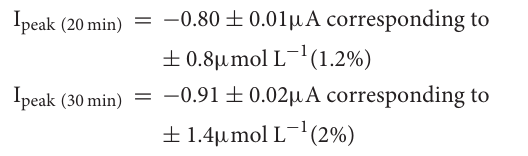
Frontiers in Marine Science |